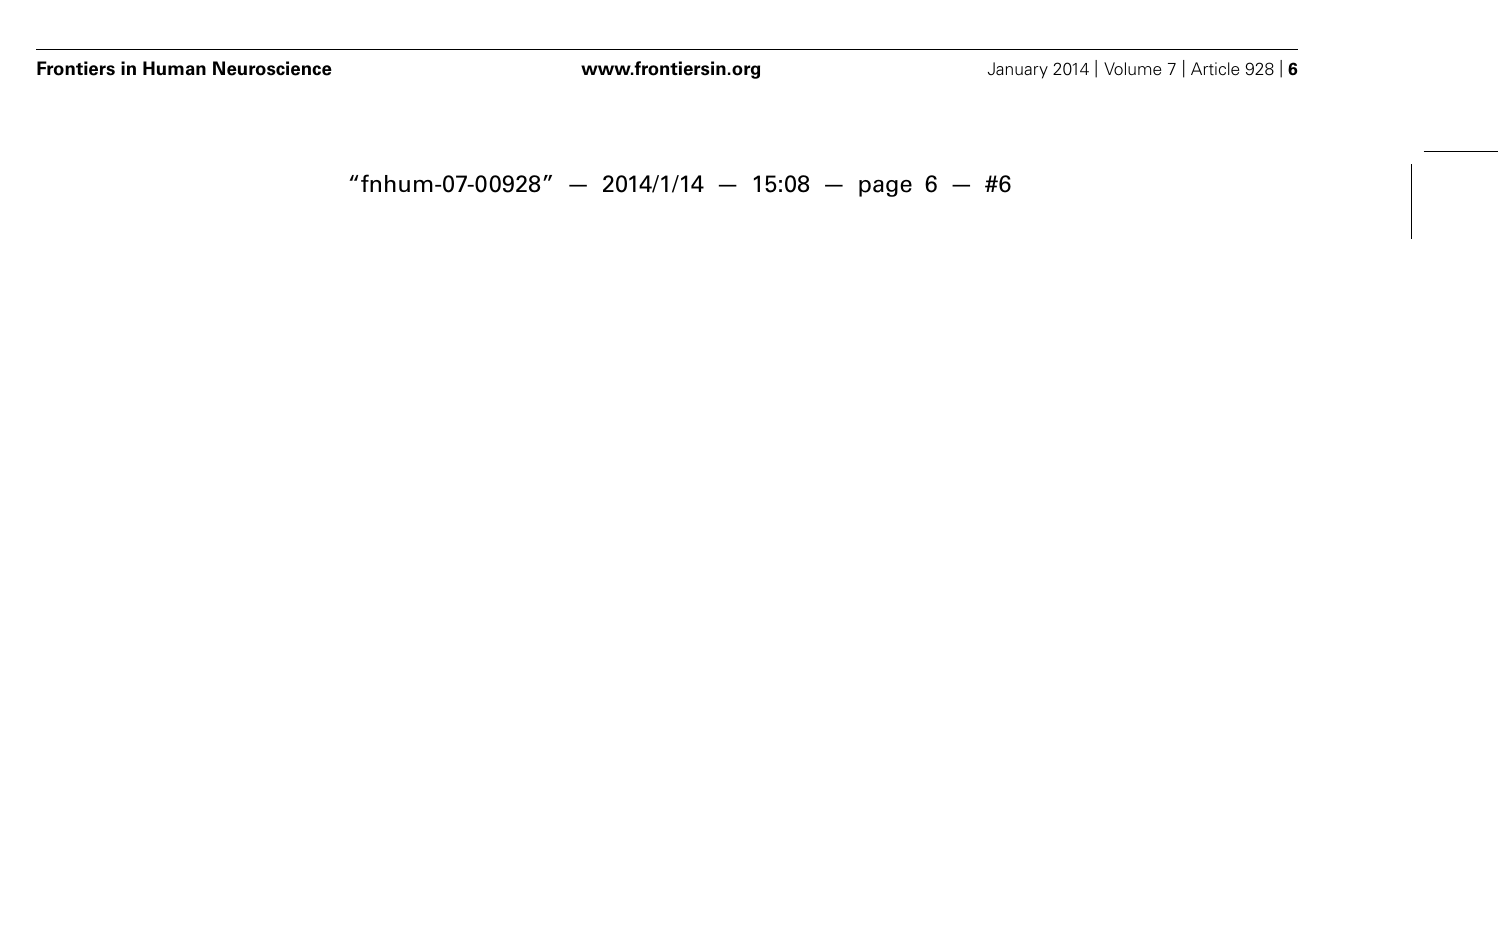
FIGURE 3 | Mean modulation of beta band CMC amplitude in PD patients following 10 Hz, 20 Hz, and sham tACS. Patients performed the isometric contraction with the more severely affected right forearm. Baseline